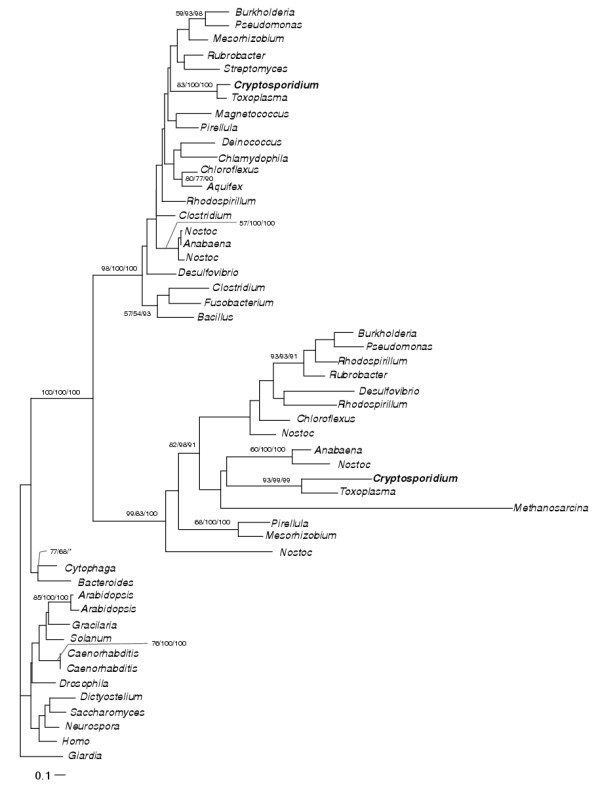
Phylogenetic analyses of 1,4-α-glucan branching enzyme. Numbers above the branches (where space permits) show the puzzle frequency (TREE-PUZZLE) and bootstrap support for both maximum parsimony and neighbor-joining analyses respectively; Asterisks indicate that support for this branch is below 50%. The scale is as indicated. GI accession numbers and alignment are provided in Additional data file 1.